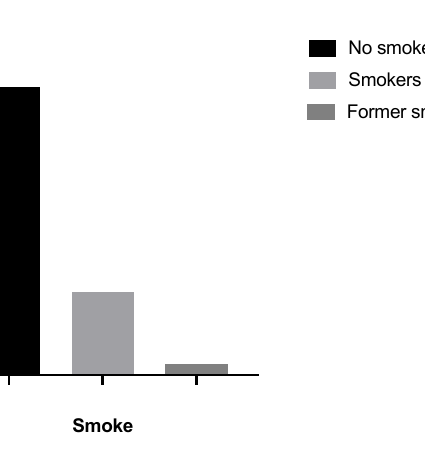
Figure 5. Smokers, non-smokers and former smokers.